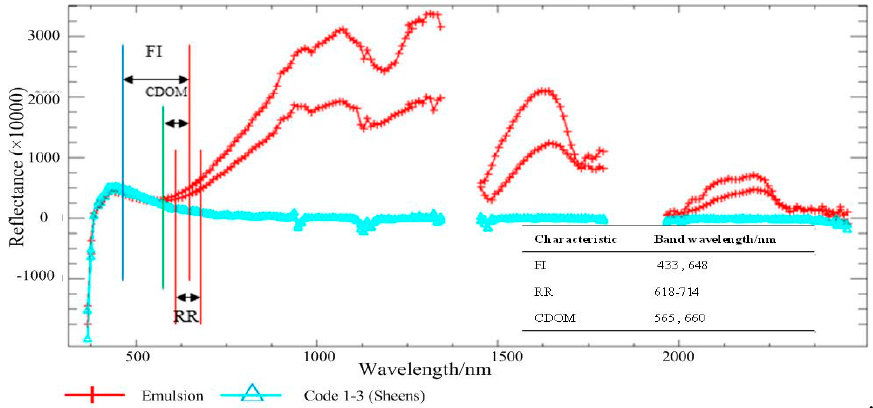
Figure 9. Spectral curve analysis identifying emulsions (red) and sheens (cyan) using FI, RR, and